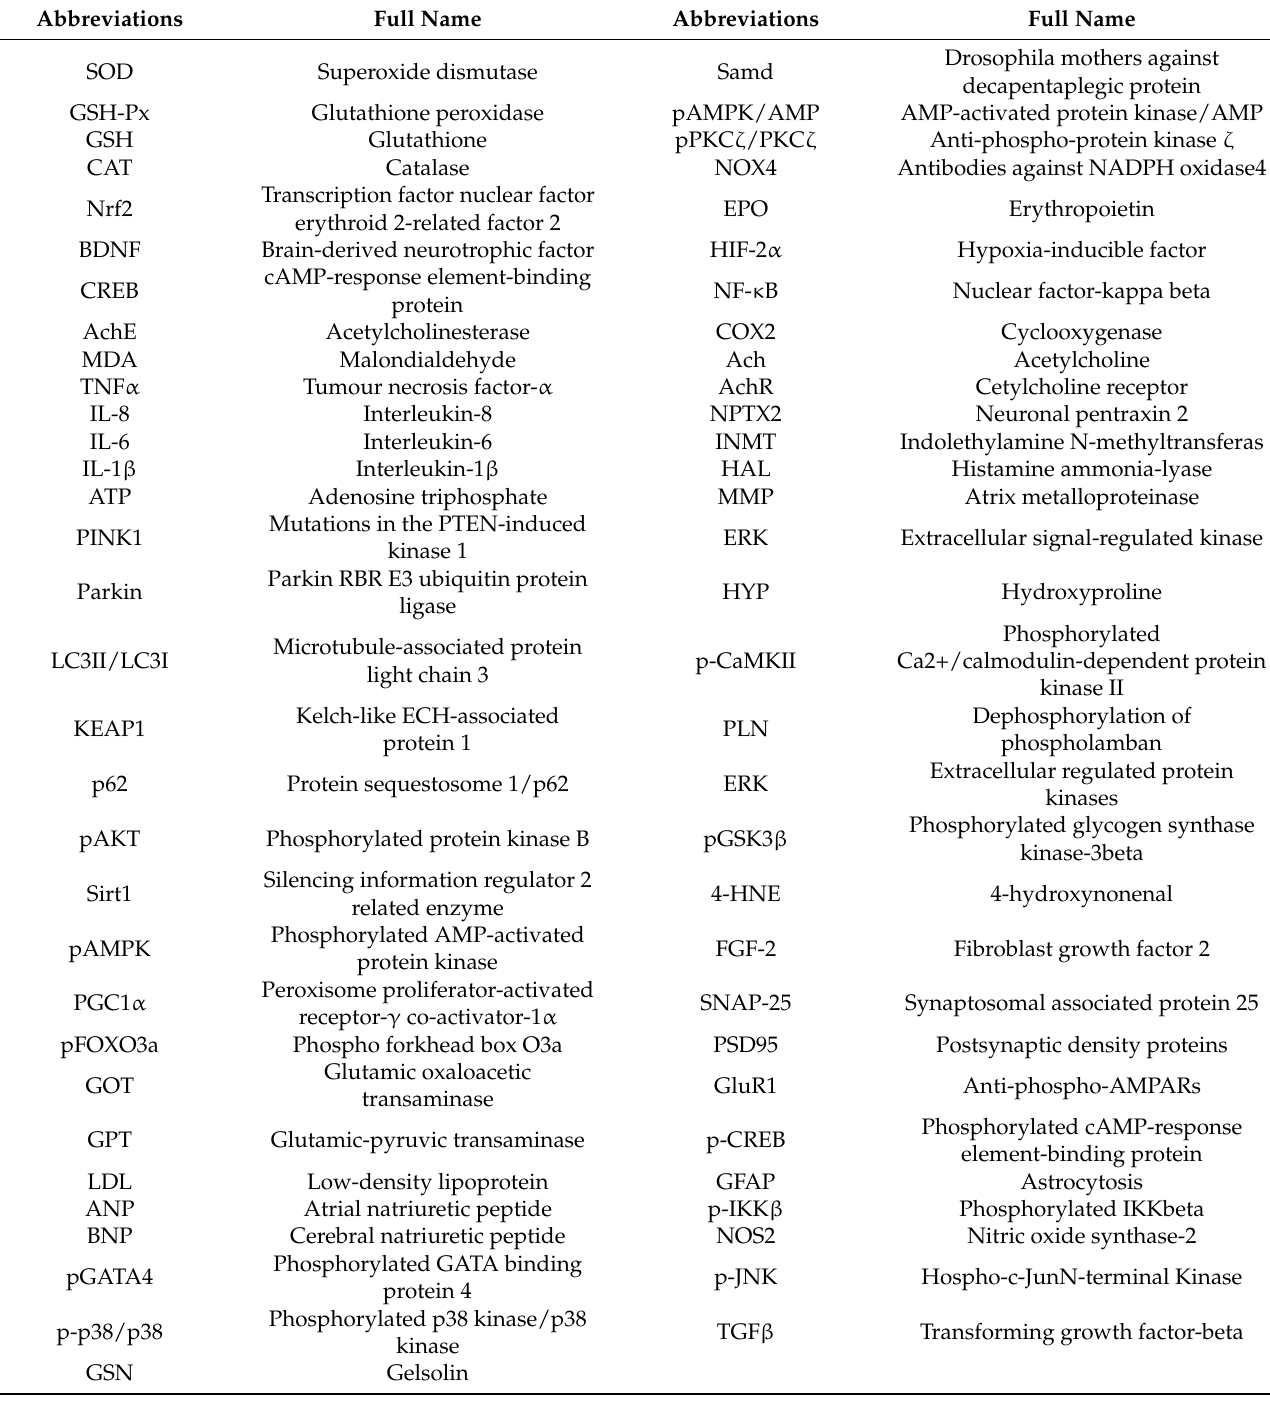
Table A1. The full name of